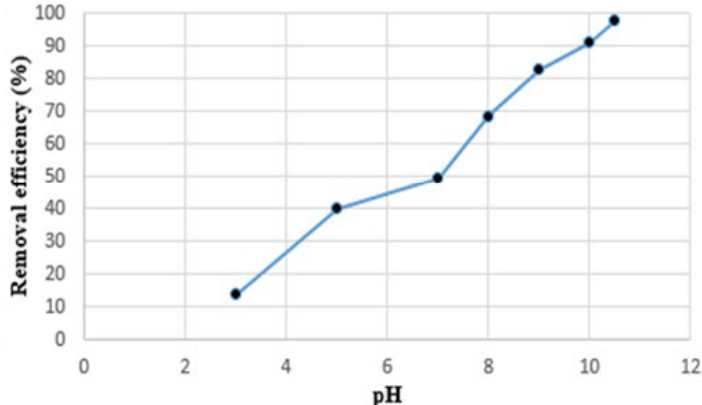
Fig. 6. pH efficacy on cadmium removal process by palladium oxide nanoparticles Fig 6. pH efficacy on cadmium removal process by palladium oxide nanoparticles